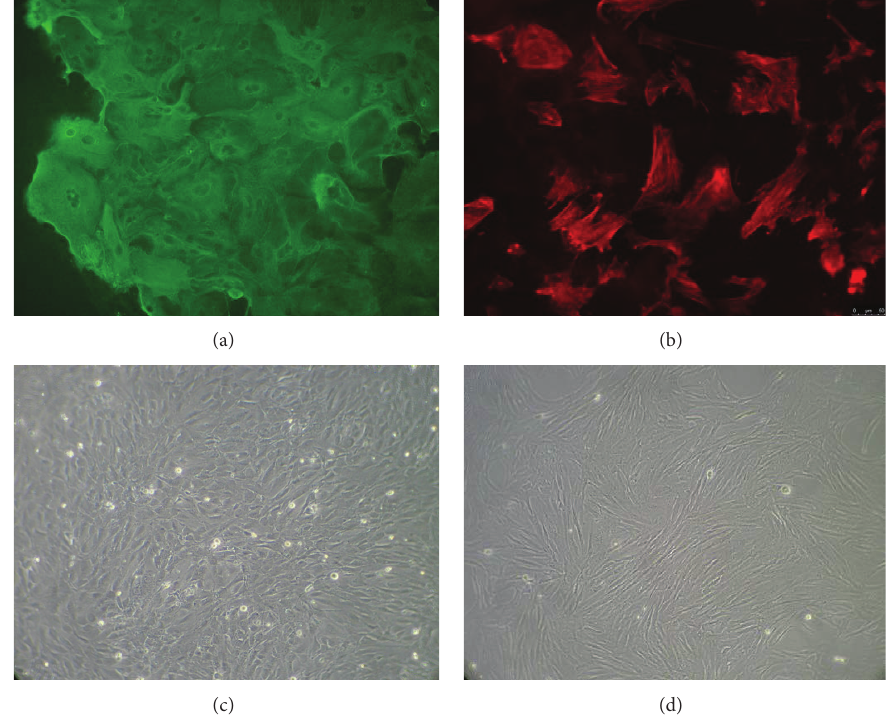
Figure1:Epithelialandstromalcellculture.Homogeneityoftheepithelial(a)andstromal(b)cellcultureswasassessedbyimmunofluorescent staining for specific markers of epithelial cells (cytokeratin) and stromal cells (vimentin). Morphology of cultured feline endometrial cells: primary cultures of epithelial (c) and stromal (d) cells under phase-contrast microscopy, on day 4 of culture.